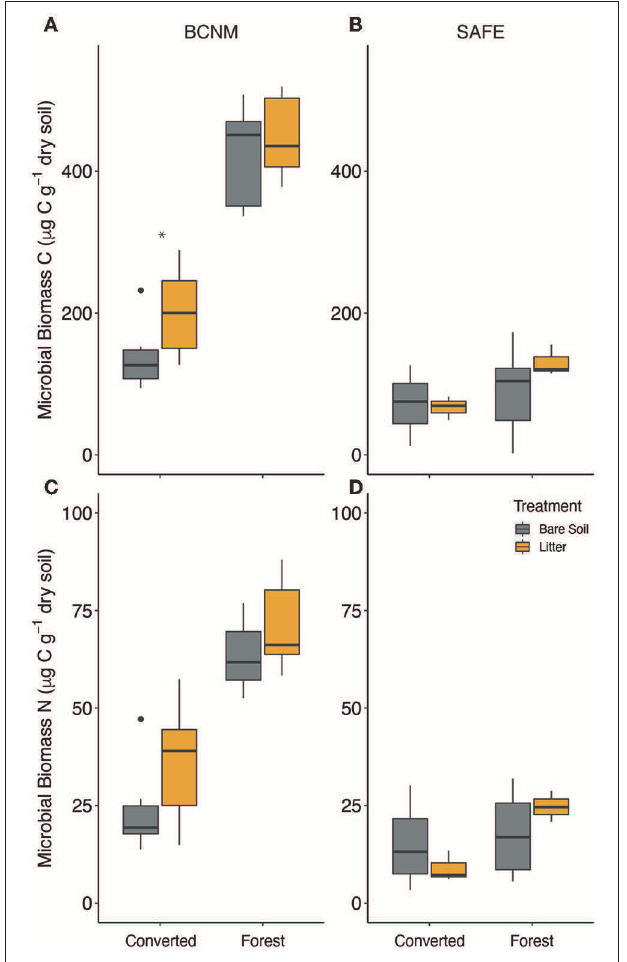
FIGURE 4 | Soil microbial biomass (A,B) carbon (C) and (C,D) nitrogen (N) at 0–10cm depth in mesocosms with either bare soil (grey) or with litter (orange) after nine months of decomposition in a tropical forest and a converted habitat at BCNM in Panama (A,C) and at SAFE in Malaysian Borneo (B,D) . Boxes denote the 25th and 75th percentiles and median lines are given for n = 6, whiskers indicate values up to 1.5 × the interquartile range, and dots indicate outliers.